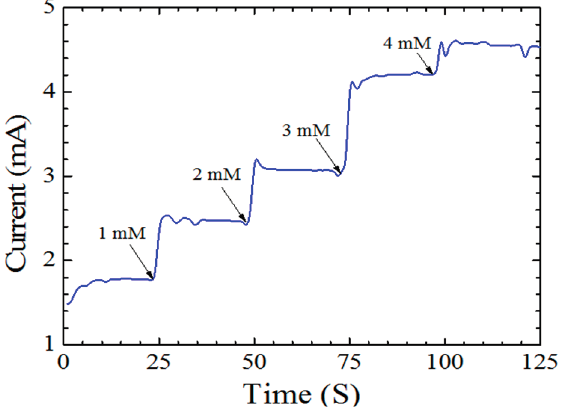
Figure 7. Amperometric response of the fabricated electrochemical sensor to different concentration of glucose with 3 s response